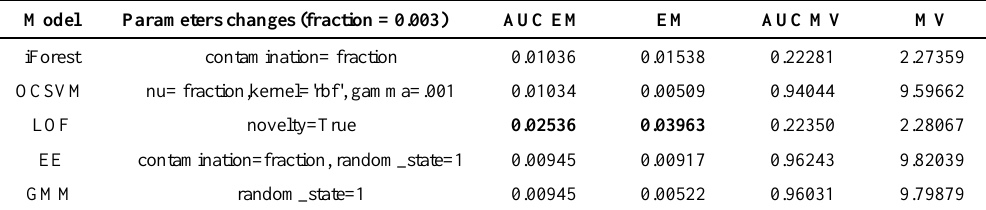
Table 4. Results for the novelty detection setting with PCA for ‘machine_temperature_system_failure’, where n_features=2. Model